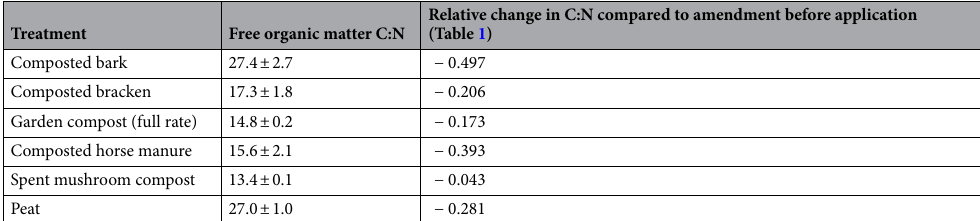
Table 5. C:N of soil fOM isolated after 7 annual applications of amendments in relation to C:N of the amendments applied.